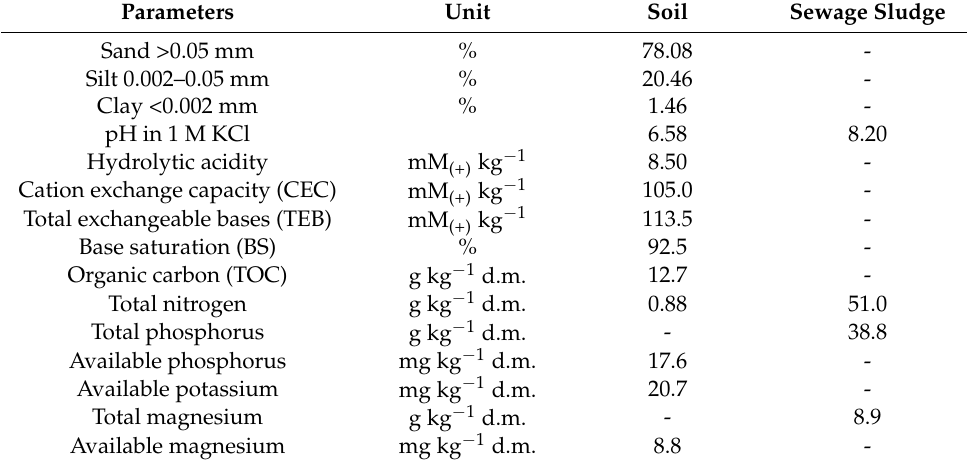
Table 1. Physicochemical parameters of soil and sewage sludge applied in experiment.